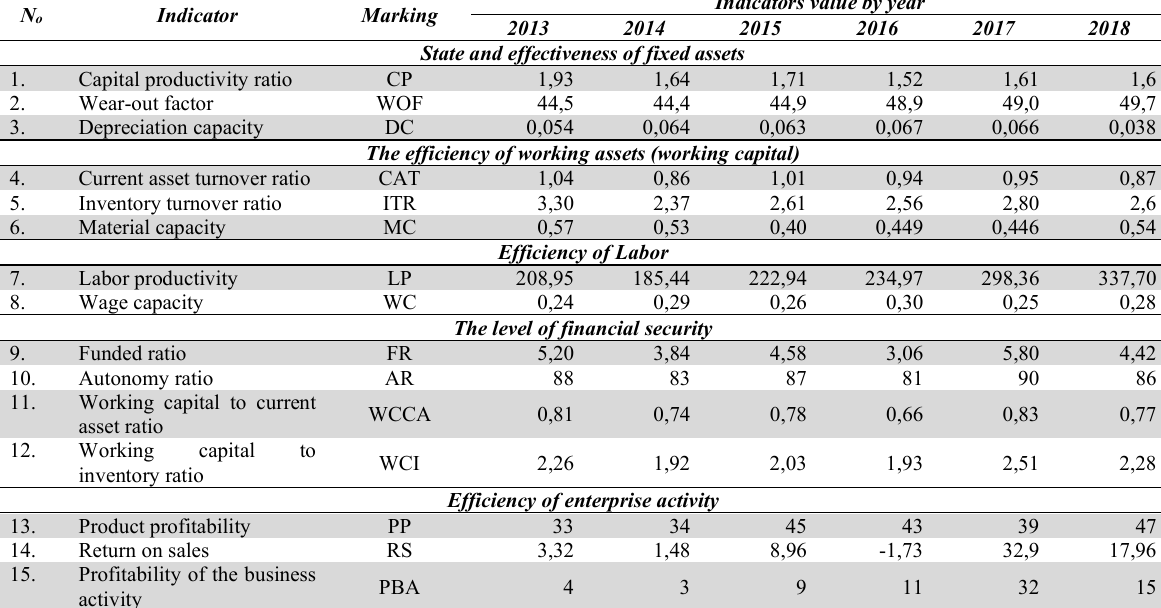
Output data of PJSC "NKMZ" for the integrated taxonomic indicator Indicator